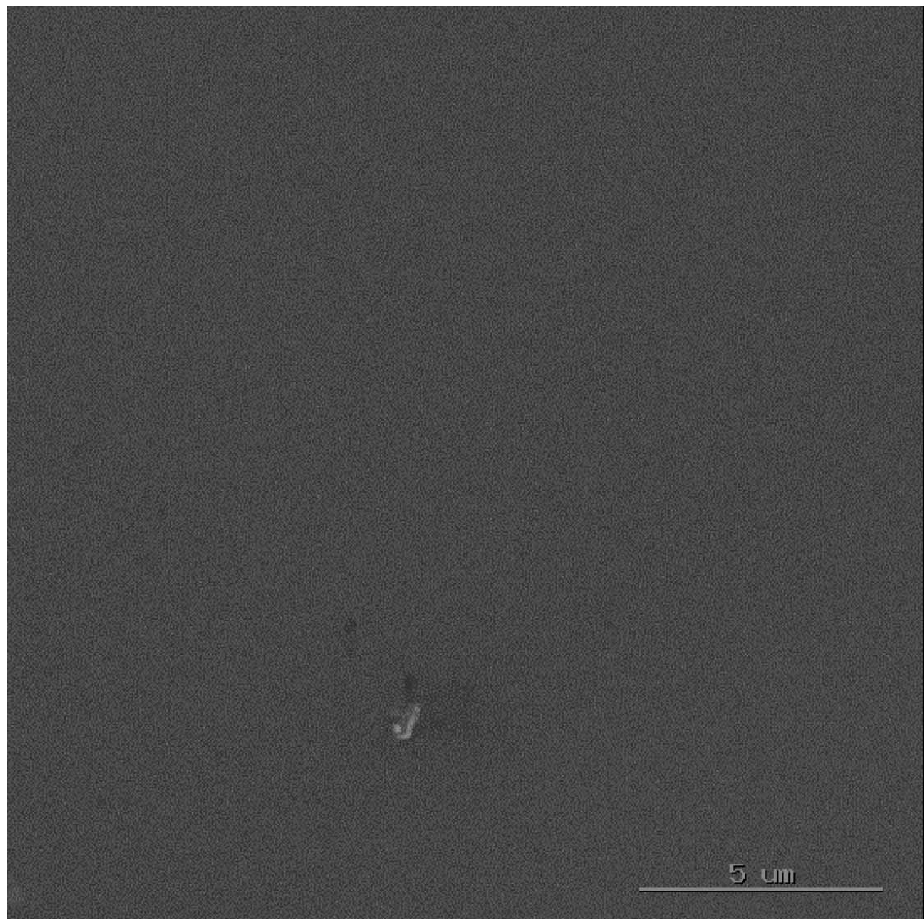
FIGURE 11 SEM for slowly cooled sample of n -Si from 400 (cid:1) C with scale of 5